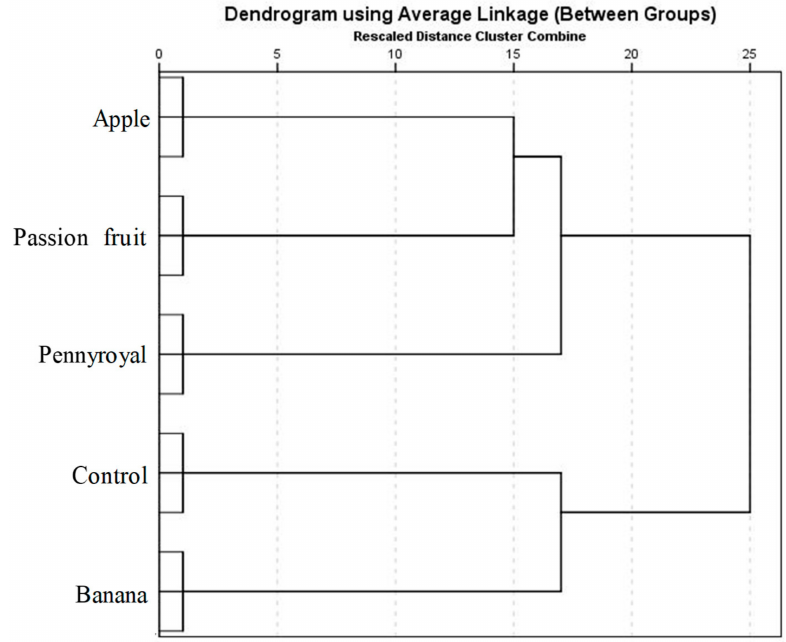
Figure 5. Dendrogram for the HCA results using Ward’s cluster algorithm of the volatile profile obtained from wine (control) and WBAV vinegars. The Square Euclidean distances are shown on the x